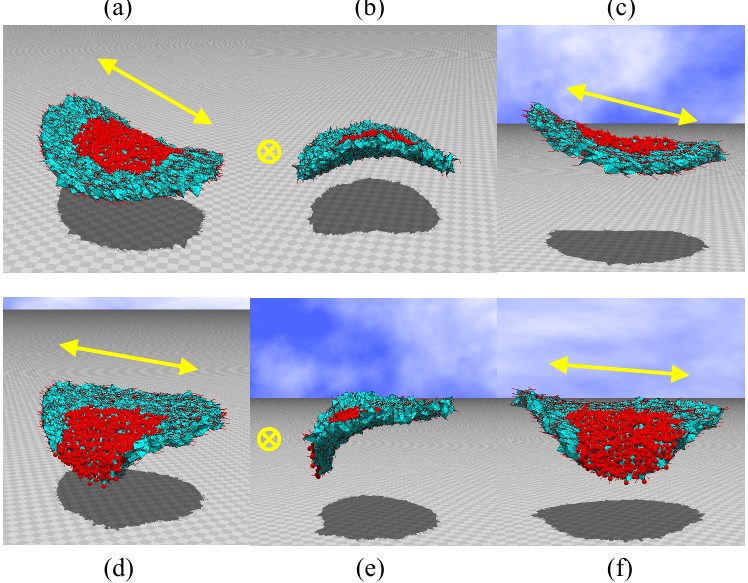
Figure 8. ( a – c ) Snapshots of disks irradiated by light at the central region, and ( d – f ) those irradiated at the region between the center and edge. The original disk size is D / H = 20 (see Figure 2c). The parameters are κ = 0.5 and λ = 1.2. N =